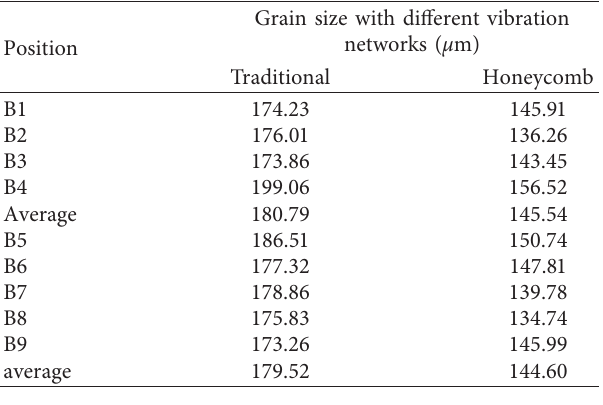
Table 3: Effects of different networks on grain size.